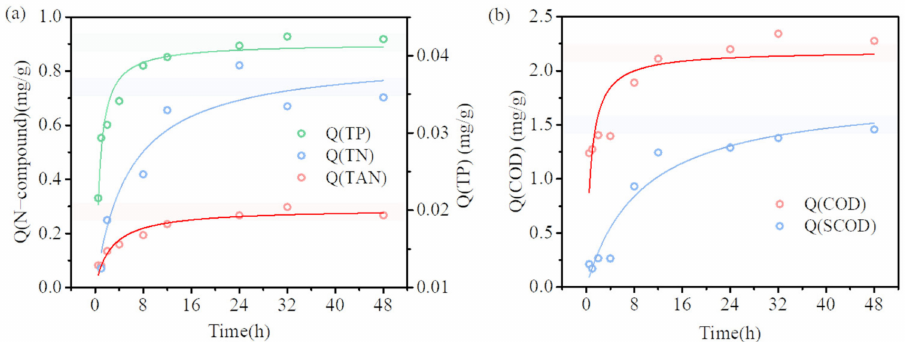
Figure 4. Adsorption kinetic models of ( a ) nutrients, ( b ) organics by soil. Note: TAN—Total ammonia nitrogen; TN—Total nitrogen; TP—Total phosphorus; COD—Chemical oxygen demand; SCOD— Soluble chemical oxygen demand.